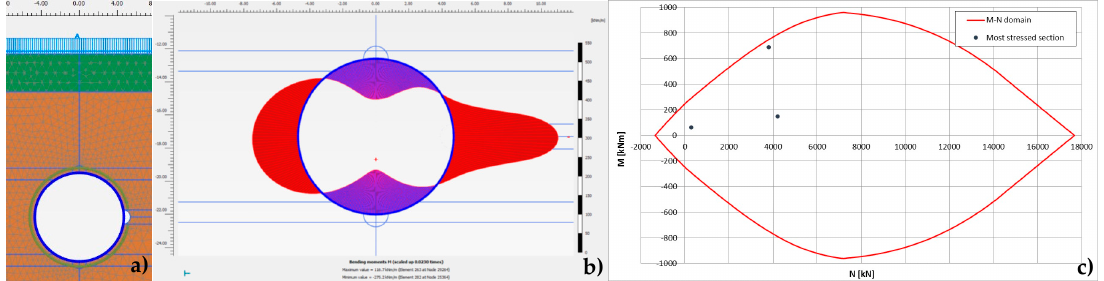
Figure 4. Tunnel Lining evaluation: ( a ) Plaxis 2D model; ( b , c ) structural verification of ring with